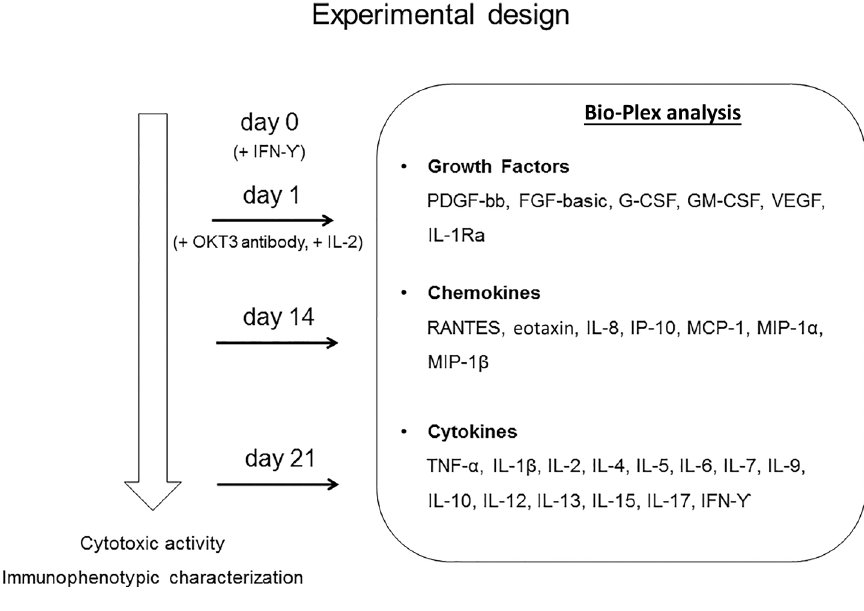
Figure 1. Bio-Plex analysis and experimental design. Secretome analysis was performed on supernatants collected at d 1 (no cytokines), d 14 and d 21 of ex vivo expansion of CIK cells. The right panel shows the complete list of growth factors, chemokines and cytokines analyzed by Bio-Plex. IFN- γ (1000 U/mL) was added at d 0, while OKT3 antibody (50 ng/mL) and IL-2 (300 U/mL) were added at d 1 and up to the end, refreshing the medium every 2–3